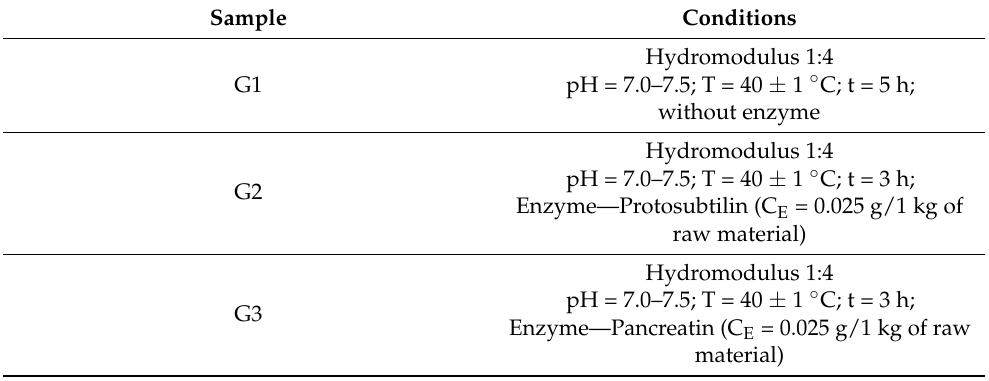
Table 1. Names of gelatin samples from cod skin and their corresponding processing